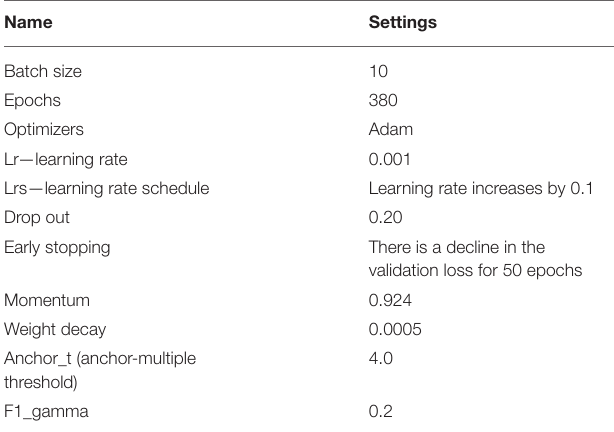
TABLE 5 | Hyperparameter